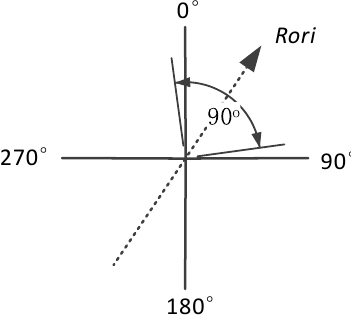
Figure 15. Coordinate system for road orientation and the uncertainty ( 45 ± ° ) of Rori shown in it.